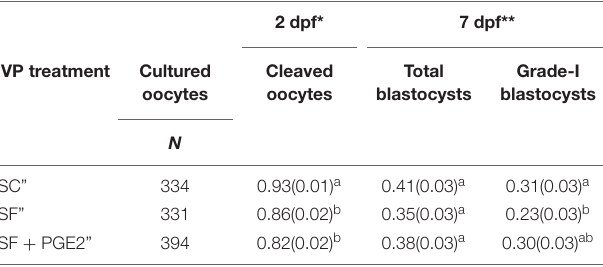
TABLE 1 | In vitro development of bovine embryos derived from experimental serum-free IVP conditions, supplemented with PGE2 (SF + PGE2), or not (SF) during IVM and IVF, in comparison to the standard serum-containing (SC) IVP